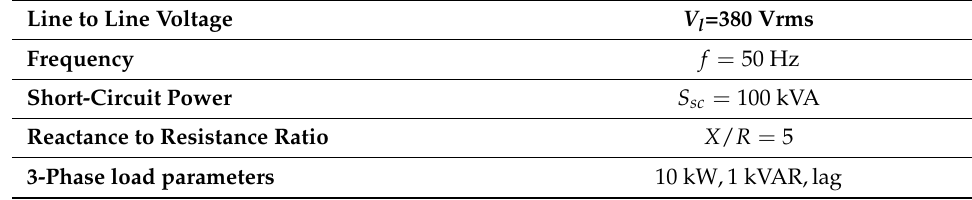
Table A2. Grid parameters.